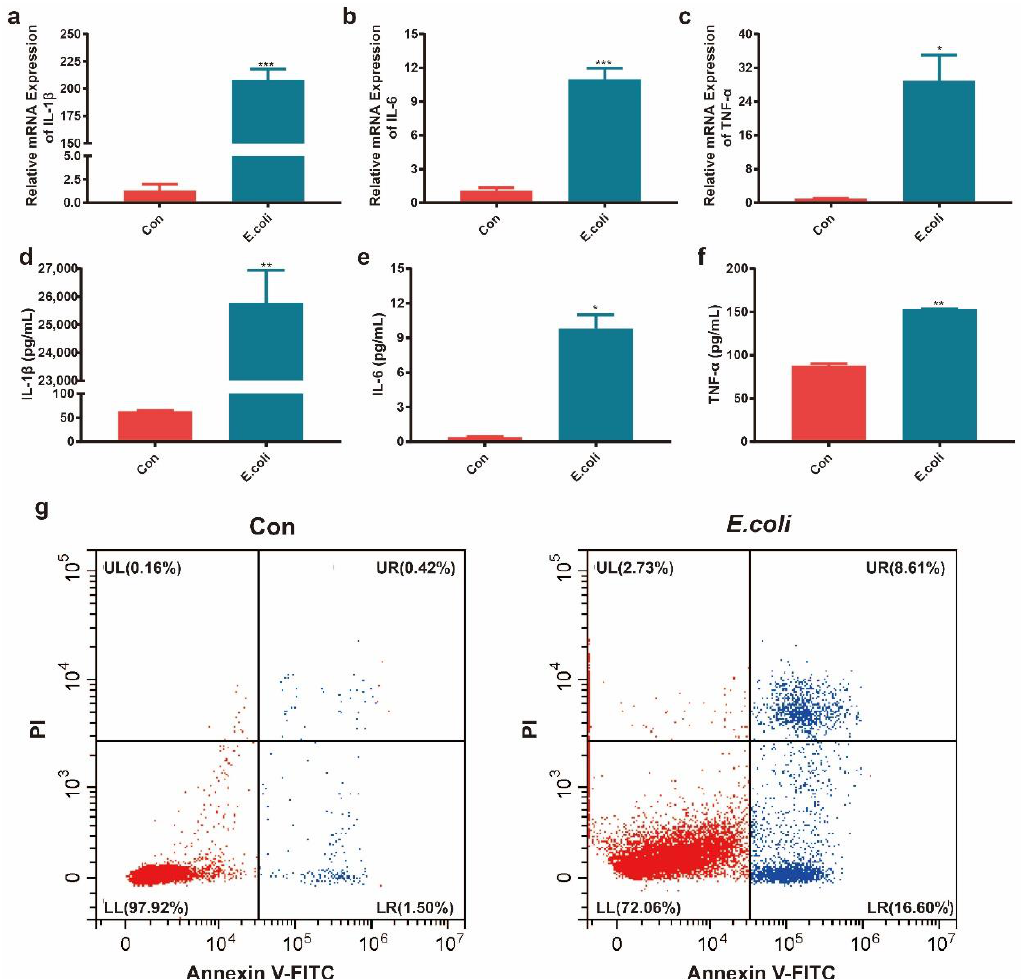
Figure 1. Inflammatory factor expression and apoptotic cell rate in the mastitis model in vitro. ( a – c ) Relative mRNA levels of IL-1 β , IL-6, and TNF- α measured using real-time PCR in the Con and E. coli groups. ( d – f ) Concentrations of IL-1 β , IL-6, and TNF- α measured using ELISA in the Con and E. coli groups. ( g ) The apoptotic cell rate in the Con and E. coli groups according to flow cytometry. Data are expressed as the mean ± standard deviation (SD) and analyzed using one-way analysis of variance; *, **, and *** represent p < 0.05, p < 0.01, and p < 0.001, respectively.